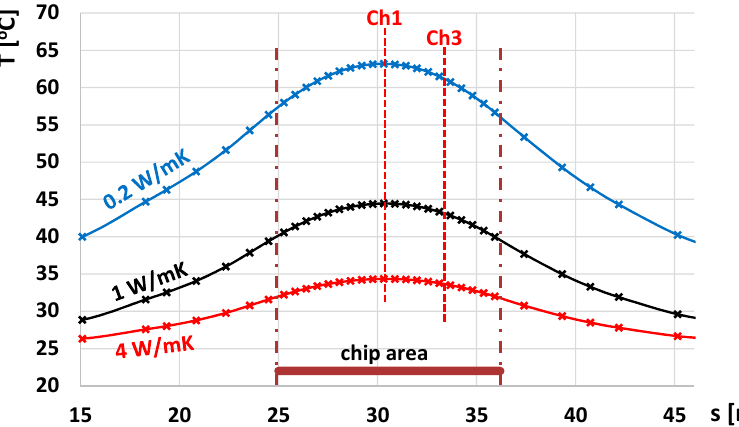
Figure 5. Temperature distribution on the case_bottom / TIM_top interface in stationary state. The peak temperature under the chip center corresponds to the final transient value at Ch1, shown as the blue, black, and red “x” in Figure 4a–c, respectively. The temperature at the displaced location Ch3 is also shown.